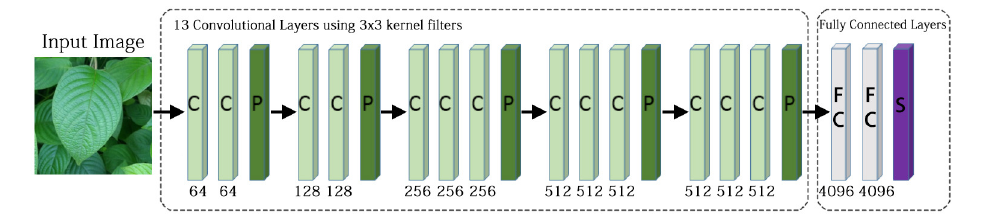
Figure 5. VGG16 model